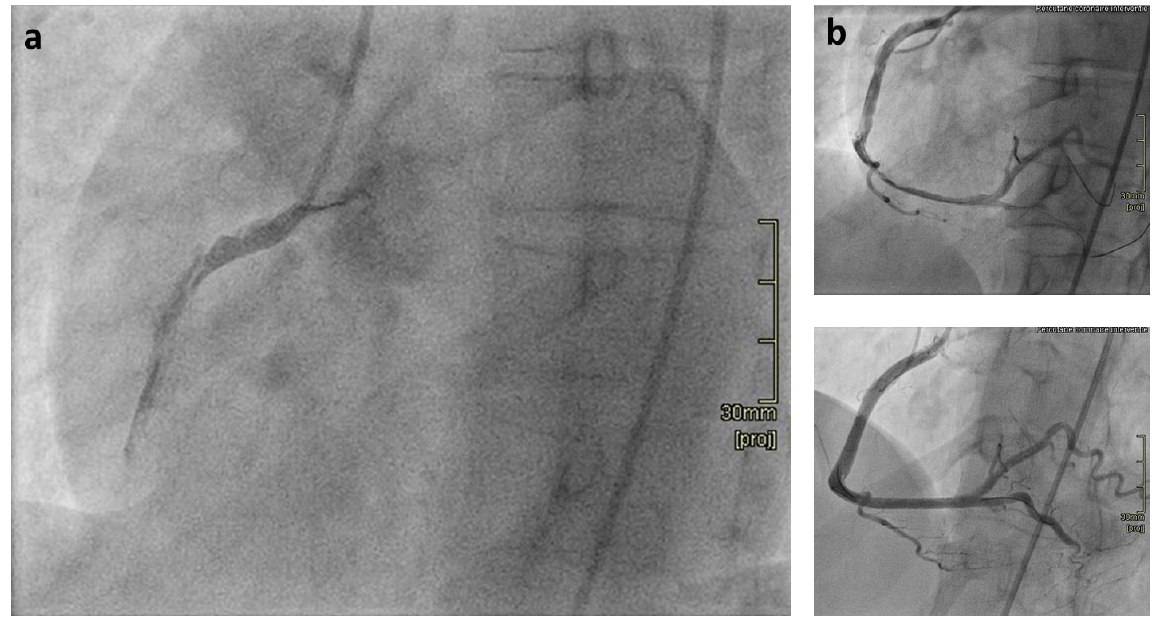
Figure 1. ( a ) Type F coronary dissection, caused by a Type 4 SCAD, of the right coronary artery (RCA) before intervention; TIMI flow grade 0. ( b ) Above Restoration of flow after wiring, however widespread coronary dissection and diminished coronary flow remain. Below Result after percutaneous coronary intervention with four drug-eluting stents with restoration of coronary flow.